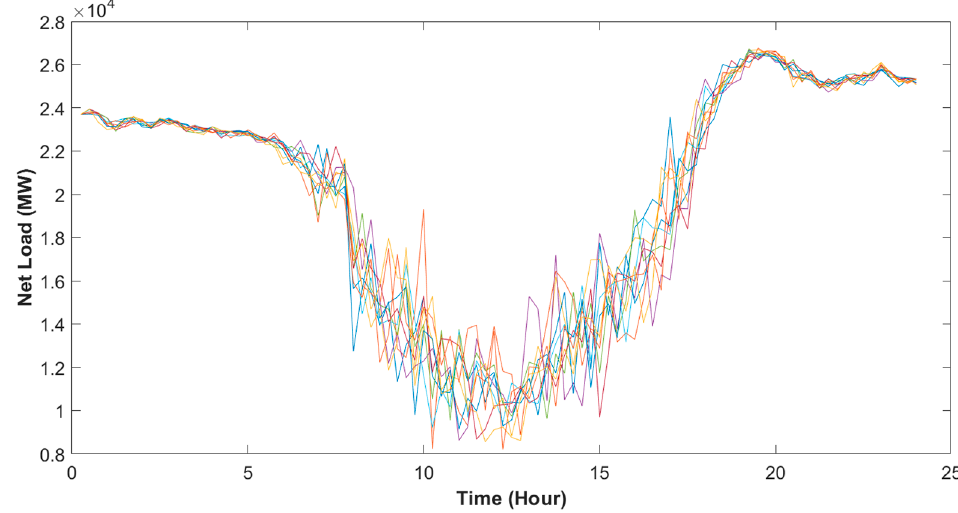
Figure 9. Renewable-energy variation “high” in 10 sets of net-load scenarios in summer.